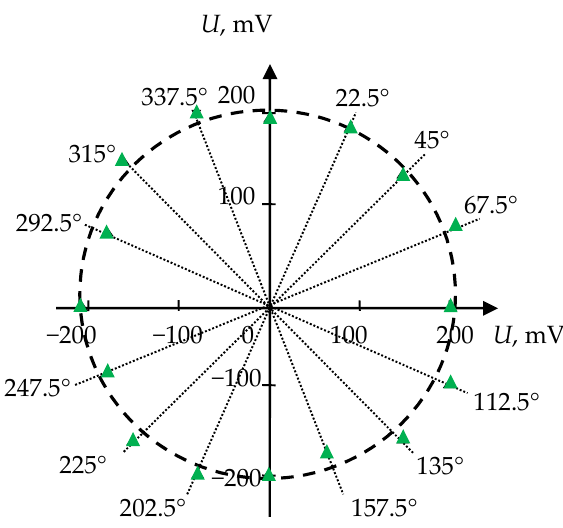
Figure 8. The experimental results: the dependence of the received signal amplitude on the angle of rotation of the receiving piezoelectric plate.